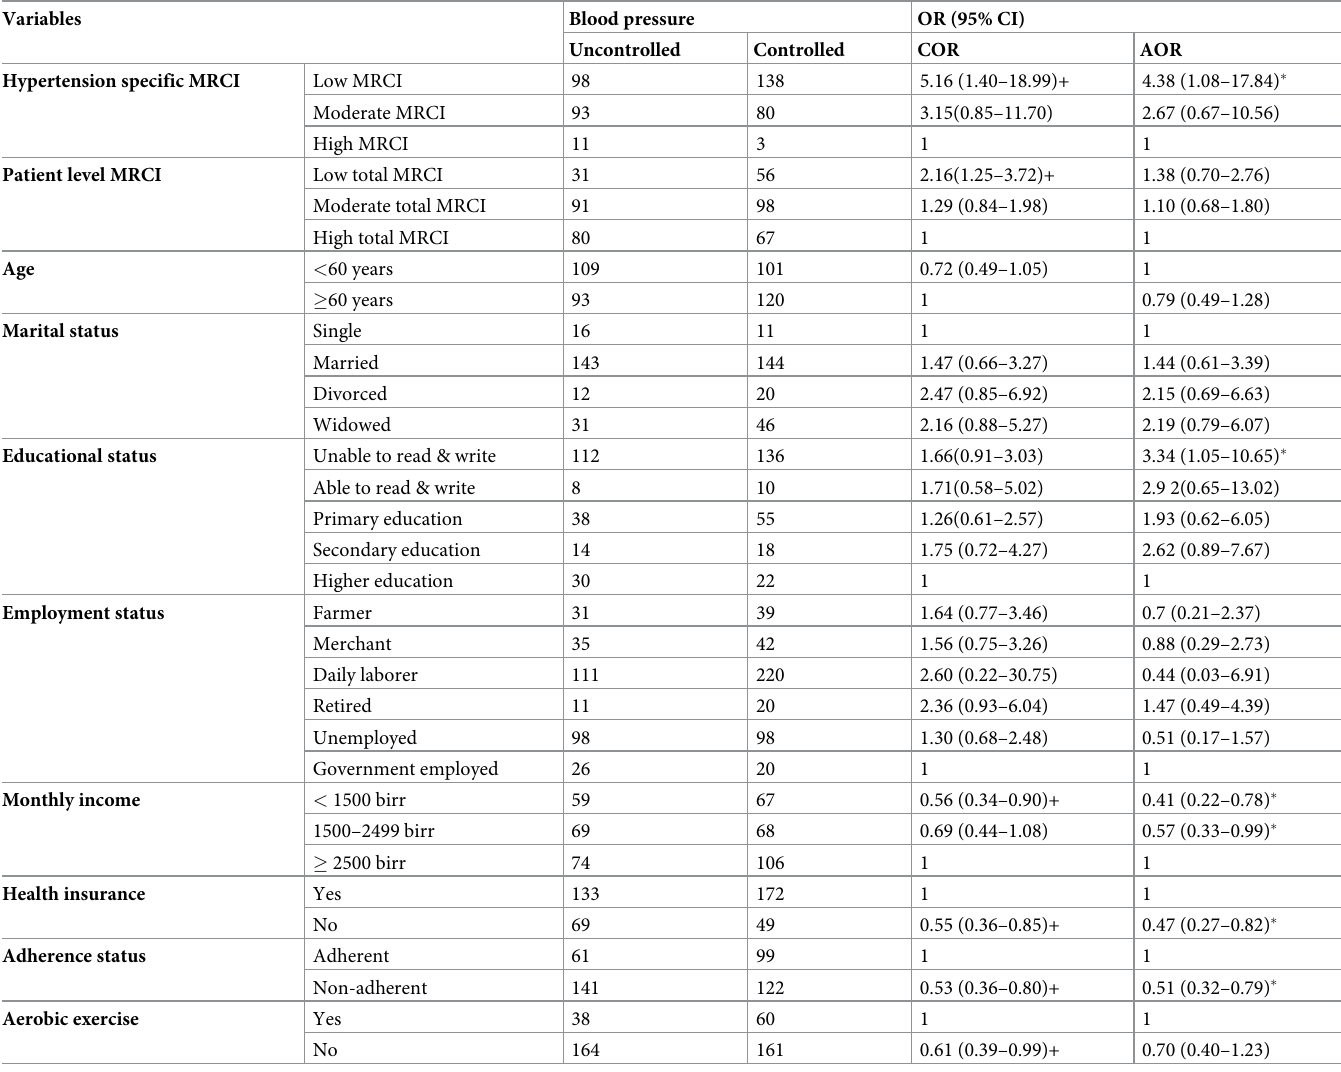
Table 4. Determination of the association between predictive variables and blood pressure